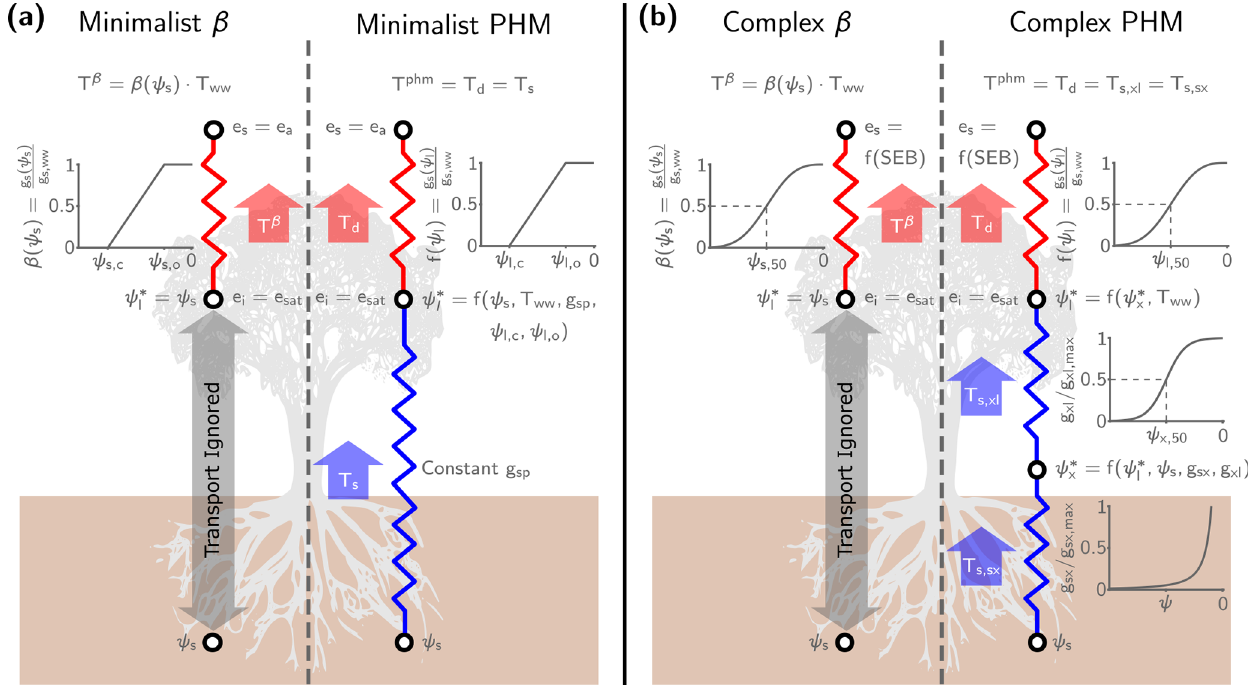
Figure 1. Schematic for the minimalist (a) and complex (b) β and PHM models used in this analysis. The resistors represent the conductance between soil–plant segments (i.e., an analogy to Ohm’s law) that mediate liquid water supply (blue) and atmospheric water vapor demand (red). Next to each resistor is the segment-specific conductance downregulation curve dependent on water potential ( ψ ). The white circles indicate segment endpoints where we calculate the potentials ( ψ ) for liquid water transport and vapor pressures ( e ) for water vapor transport. The supply segment subscripts represent soil (s), xylem (x), leaf (l), and bulk soil-plant (sp), whereas the demand segment subscripts represent inside the leaf (i), at the leaf surface (s), and the ambient air (a). For water vapor transport, we assume saturation vapor pressure inside the leaf ( e i = e sat ) for both models. In the minimalist models, we assume the leaf surface vapor pressure ( e s ) is the atmospheric vapor pressure ( e a ), which makes the driving force for water vapor transport the leaf-to-air vapor pressure deficit ( D = e sat − e a ). Alternately, in the complex models, e s is a function of the surface energy balance ( f ( SEB ) ) calculations at each time step. The thick arrows represent the water transport through each segment calculated by the integrated steady-state flux-gradient relationships discussed in Sect. 2.1–2.2 and 2.5. We use the minimalist models (left panel) for Sect. 3.1–3.2 and the complex models (right panel) for the LSM analysis in Sect. 3.3. (Note that we only illustrate a single big-leaf formulation here, but see Sect. S2 for the two-big-leaf